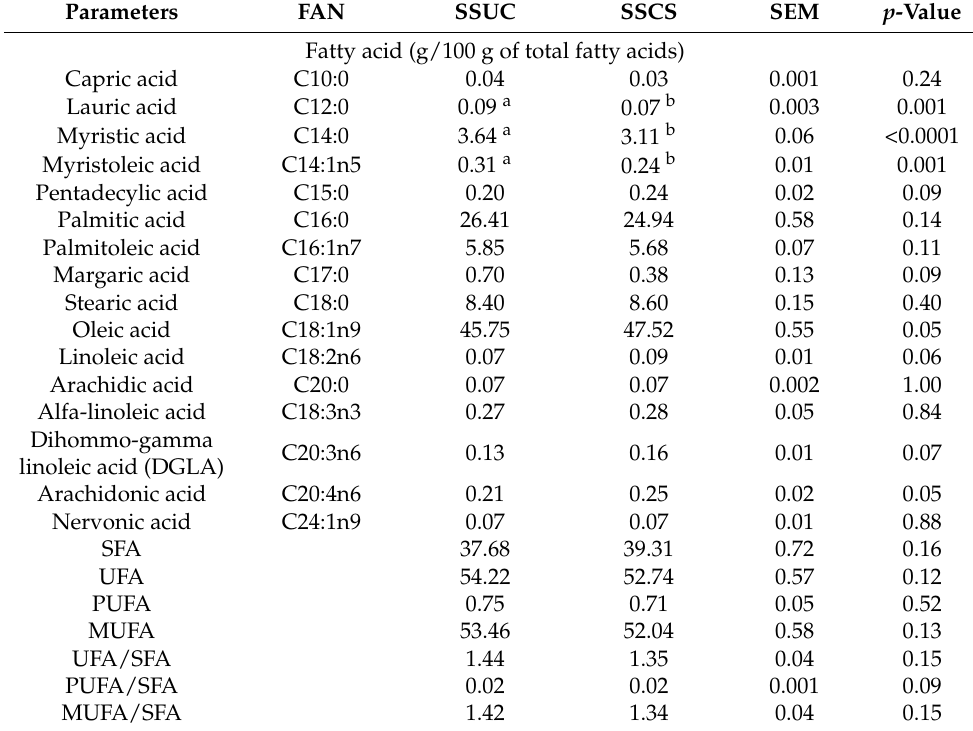
Table 2. Effect of slaughtering with or without state of consciousness on Longissimus dorsi muscle’s fatty acid pattern in Korean Hanwoo Finishing Cattle.